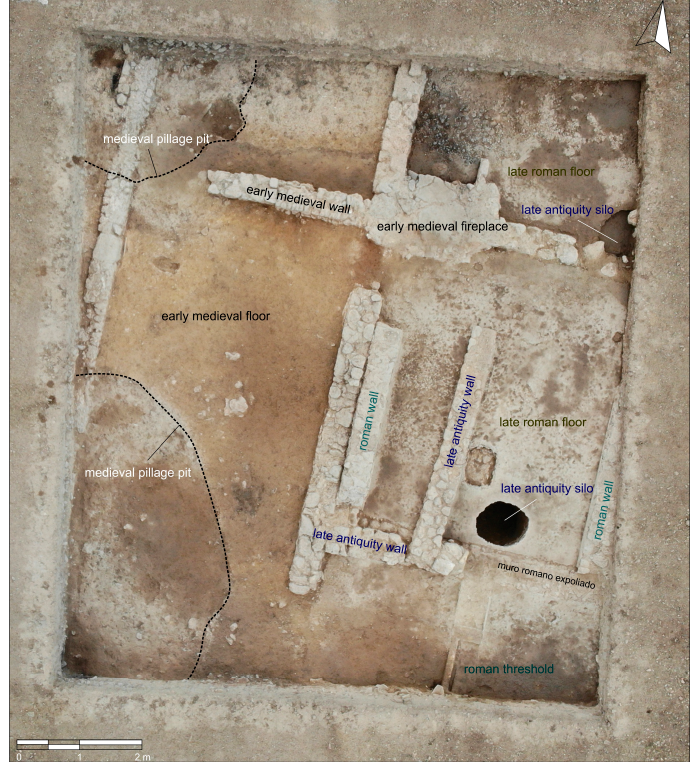
Figure 11. An orthophoto of the excavation to the west of the area that was excavated in the 1970s, showing details of the Late Antiquity and Medieval reoccupation of an old building, where spaces had been compartmentalised, and where silos and other domestic structures had been